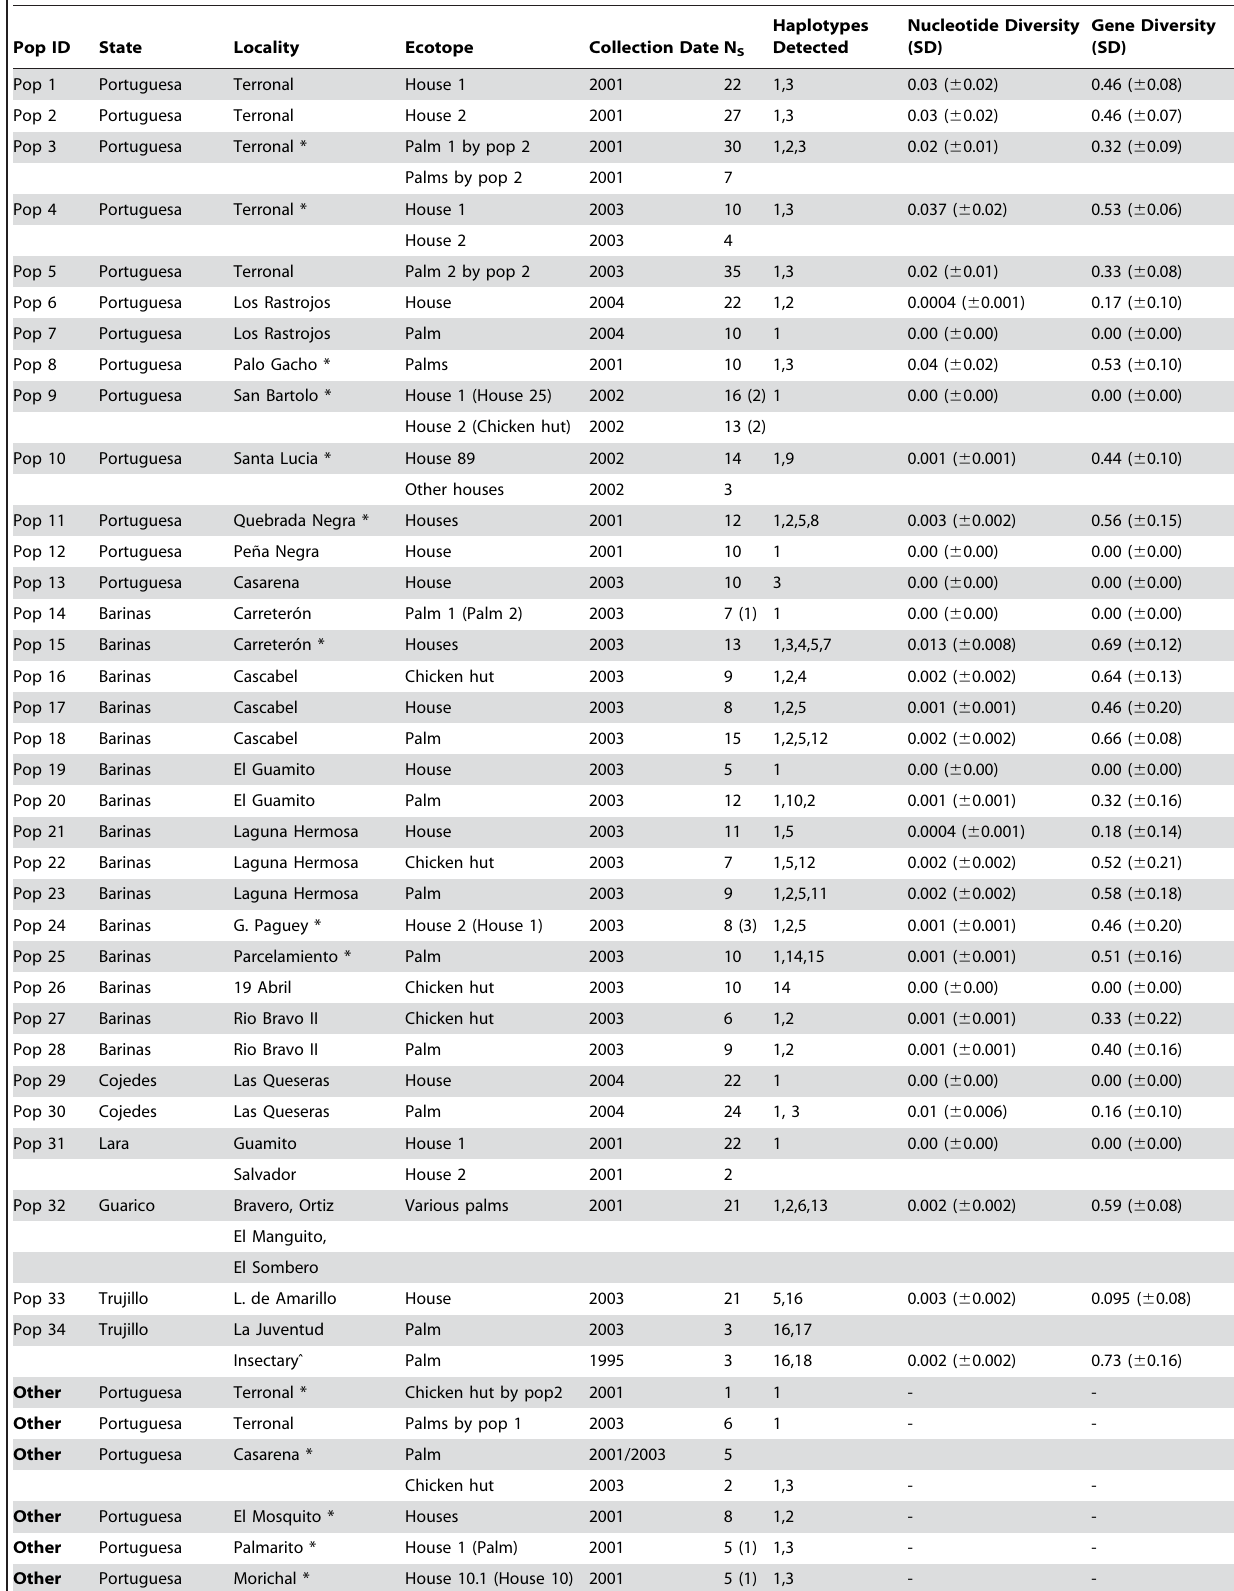
Table 1. Details of the 34 populations analysed by direct